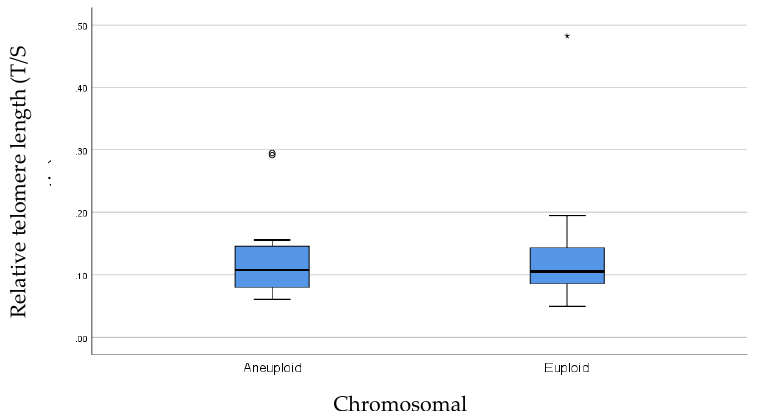
Figure 5. Relative telomere length of aneuploid first polar bodies ( n = 12) in comparison to euploid first polar bodies ( n = 12) assessed in all women. Results show no significant difference ( p = 0.39). The line on the lower end of the whisker represents the minimum T/S ratio, the bottom of the box represents the first quartile, the line through the middle region of the box represents the median T/S ratio, the top of the box represents the third quartile, and the line at the top of the whisker represents the maximum T/S ratio. Circles represent outliers between 1.5 and 3 box lengths from the upper region of the box. Asterisks represent extreme outliers that are more than three times the interquartile range from the third quartile.